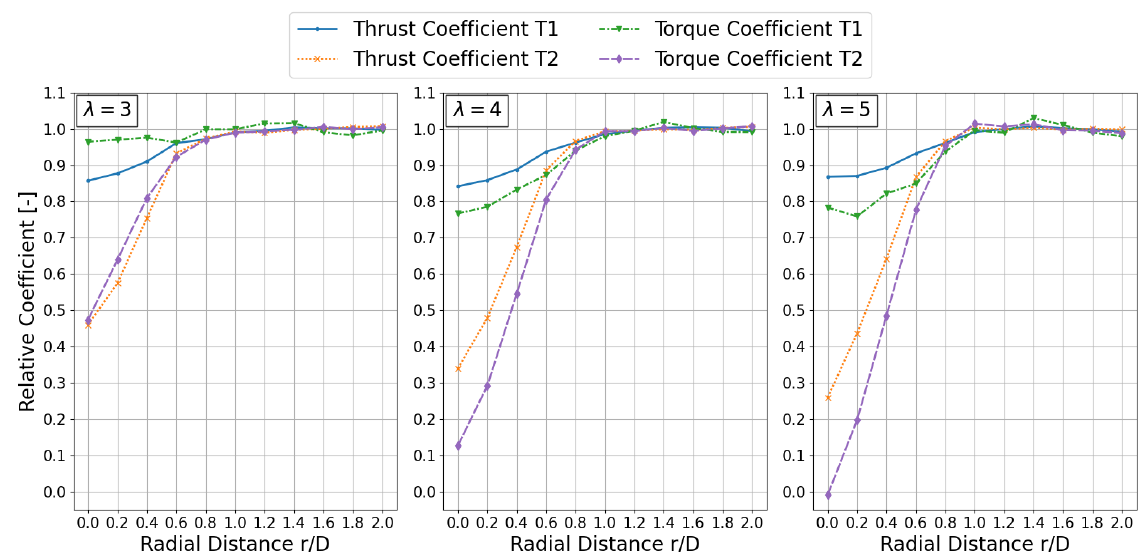
Fig. 6. Measured coefficients normalized with the mean of the cases r/D ∈ [1 . 2 , 2 . 0] . T1: upstream turbine. T2: downstream